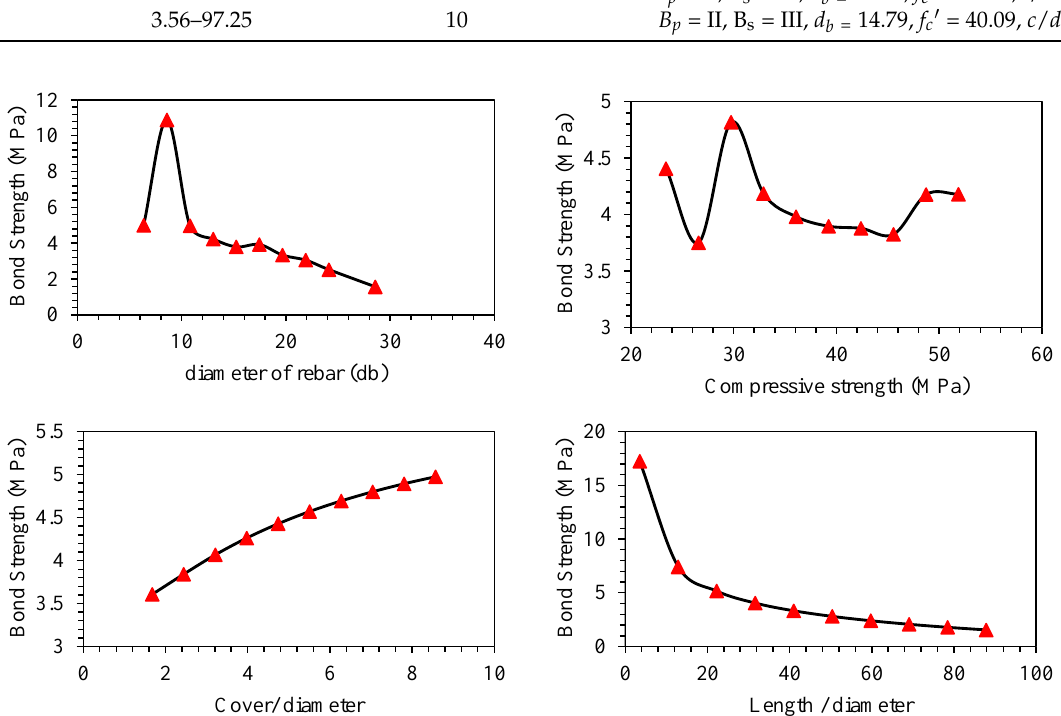
Figure 11. Effect of the contributing parameters on BS for bar position ( B p ) type-I and B s type 1.